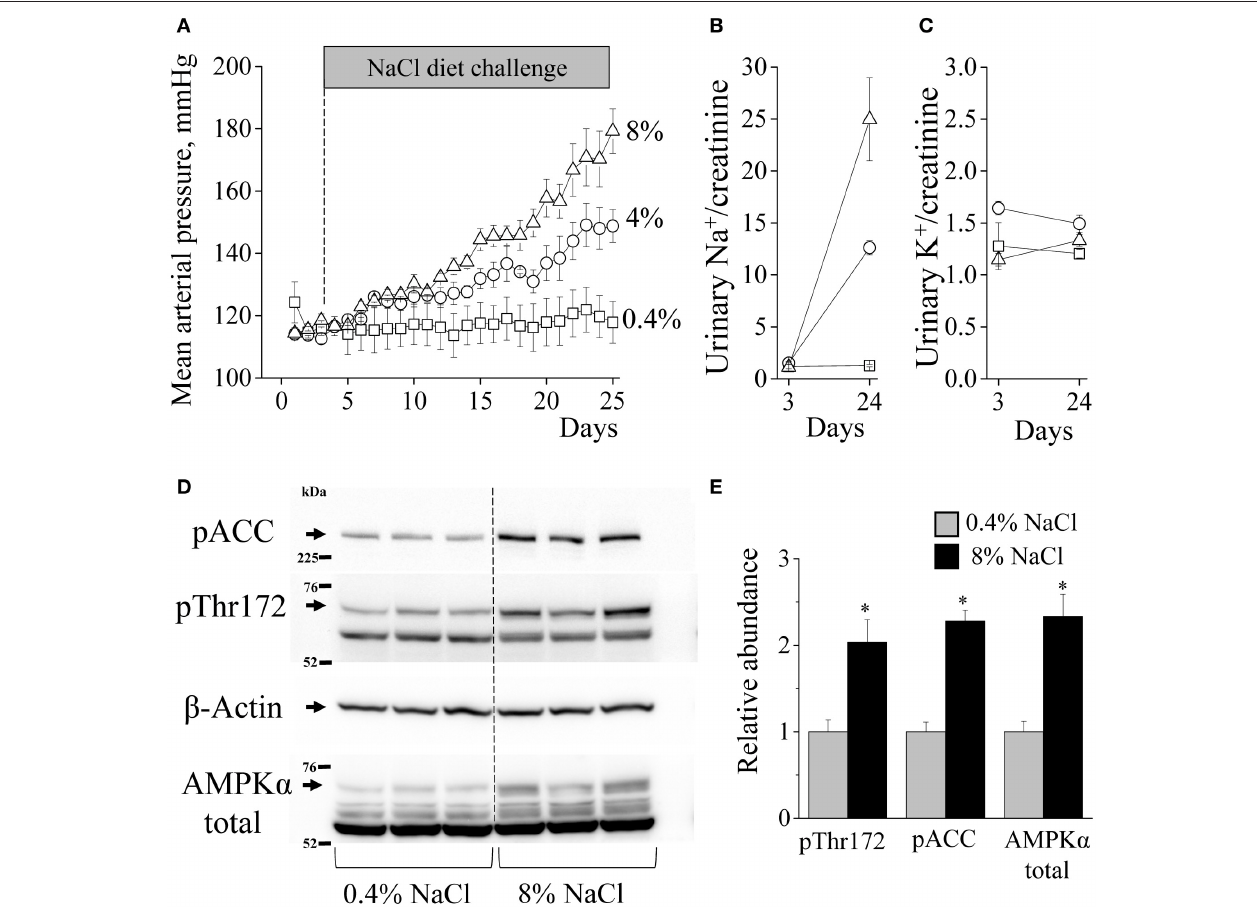
FIGURE 1 | AMPK activity is increased in salt-induced hypertension. (A) Mean arterial blood pressure in Dahl SS rats fed a 0.4% ( n = 4), 4% ( n = 3), or 8% ( n = 5) NaCl diet measured with DSI telemetry. Sodium (B) and potassium (C) urinary excretion (mM/mg of creatinine) before and after diet challenge ( n = 5 in each group). (D) Western blot of kidney cortex lysates isolated from the animals on 0.4 and 8% diets. Samples were tested for expression of phosphorylated acetyl-CoA carboxylase (pACC) and AMPK α levels as indicators of AMPK pathway activity. (E) Summary graph of pThr172-AMPK α , p-ACC and AMPK α abundances, along with β -actin as a loading control (* p < 0.05 vs. 0.4% NaCl for each parameter, unpaired t -tests, n =